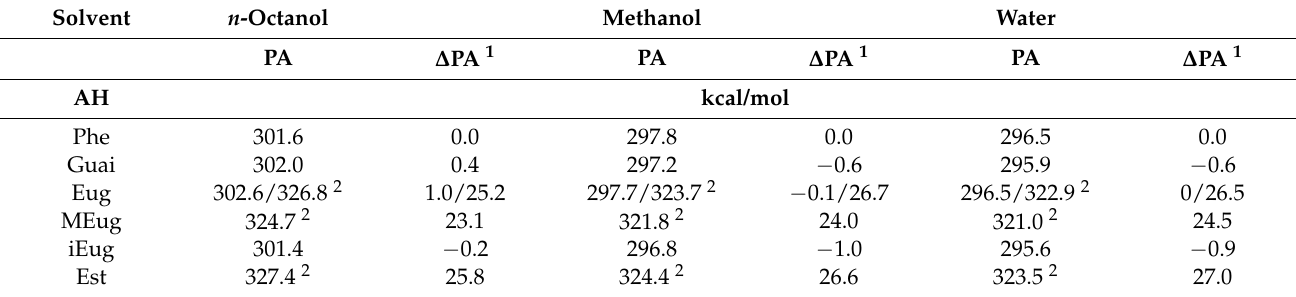
Table 4. Absolute and relative ( ∆ ) PA values (kcal/mol) of the test compounds in n -octanol, methanol, and water at B3LYP/6-31G//B3LYP/6-311++(2d,2p)